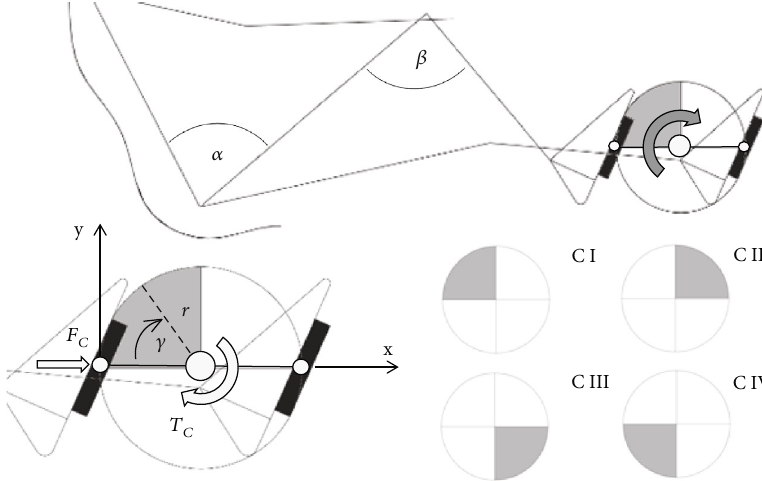
Figure 6: The crankset — model for analysis.